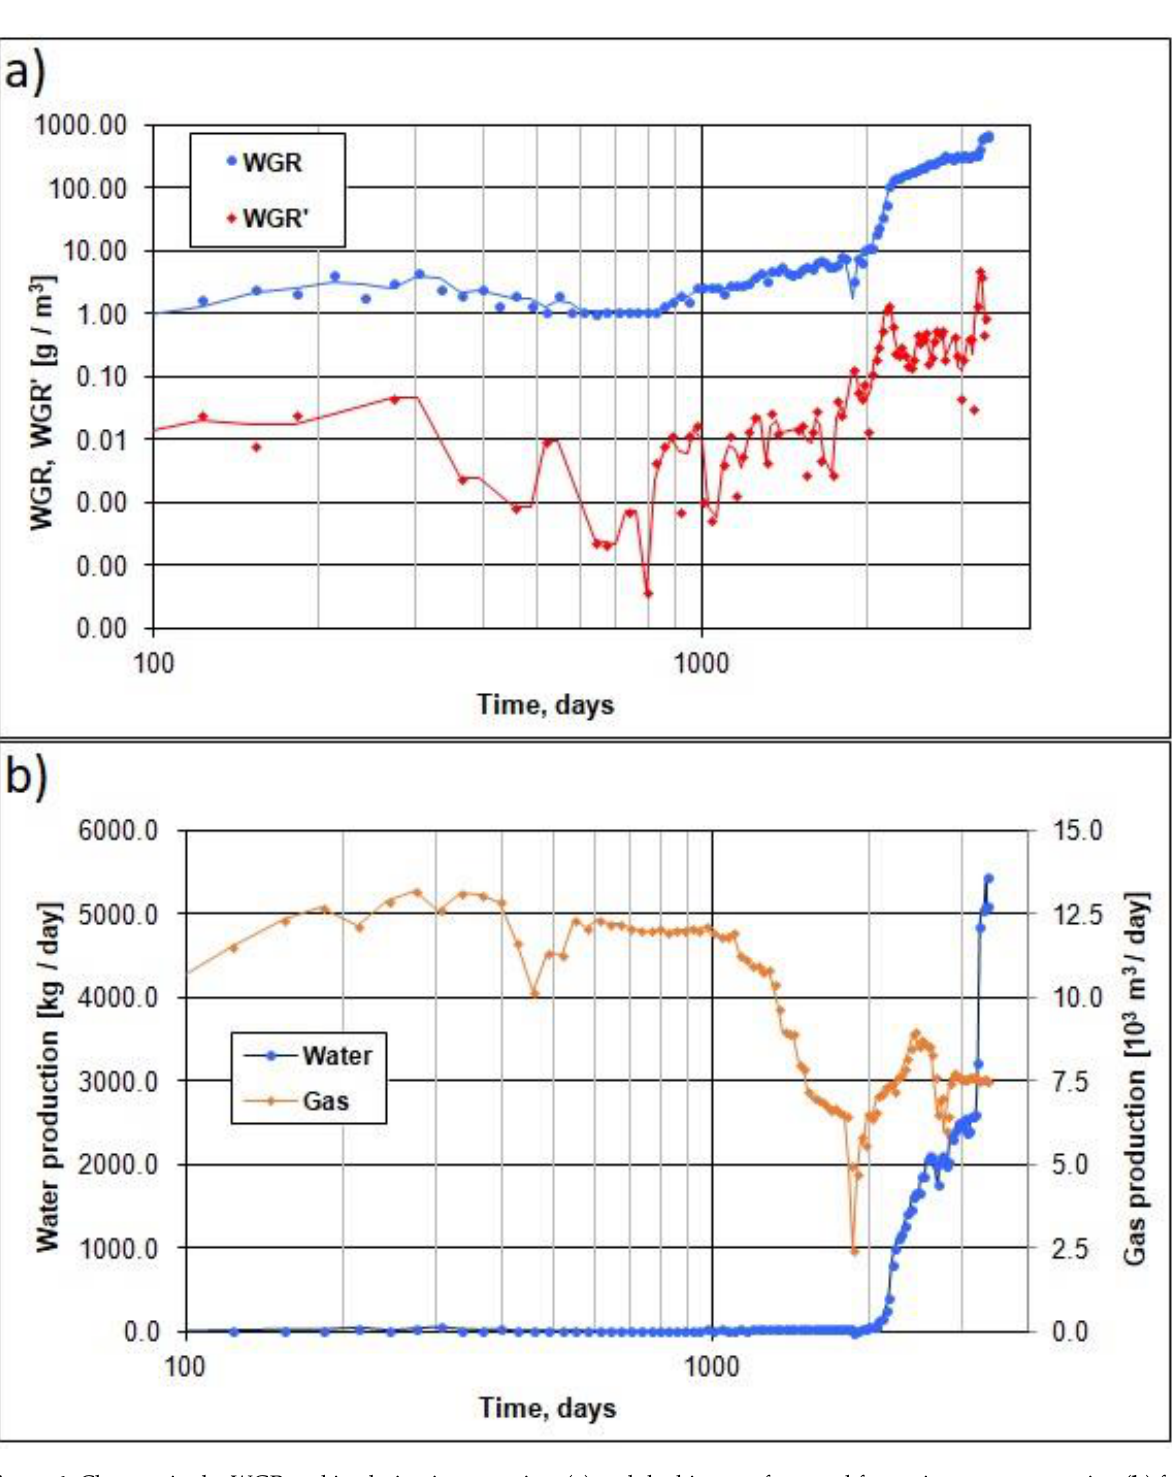
Figure 4. Changes in the WGR and its derivative over time ( a ) and the history of gas and formation water extraction ( b ) for the J-8K well .